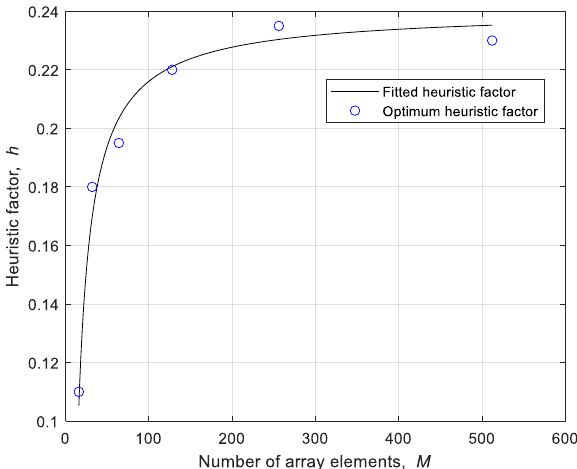
Figure 3. Heuristic factor variation with the array size.